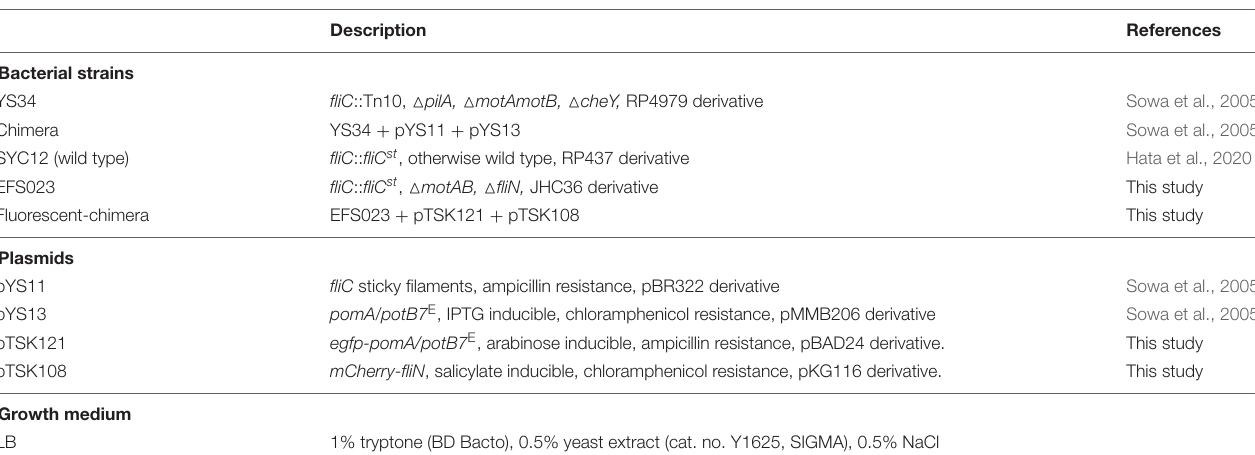
FIGURE 1 | Structure of chimeric bacterial flagellar motor. (A) Schematic of the chimeric flagellar motor side view. A stator unit can diffuse on the membrane or bind to the motor. A bounded stator unit can interact with the C ring of the rotor and drive the rotor to rotate. The stator is composed of the PomA (orange) from Vibrio alginolyticus and the chimeric PotB7 E . The PotB7 E joins the N terminus of V. alginolyticus PomA to the periplasmic C terminus of Escherichia coli MotB. The blue part is from E. coli , and the orange part is from V. alginolyticus . The chimeric stator units utilize the electrochemical energy of sodium ions (orange dots) to the motor rotation. (B) Schematics of the primary structure of a PotB7 E . The black boxes represent the identified functional areas. OM, outer membrane; PG, peptidoglycan; IM, inner membrane; TM, transmembrane. (C) Top view of the flagellar motor. Stator units dynamically assemble to a motor (Bound) or disassemble from a motor and diffuse on the membrane pool (Diffusing). TABLE 1 | The list of bacterial strains and medium used in this